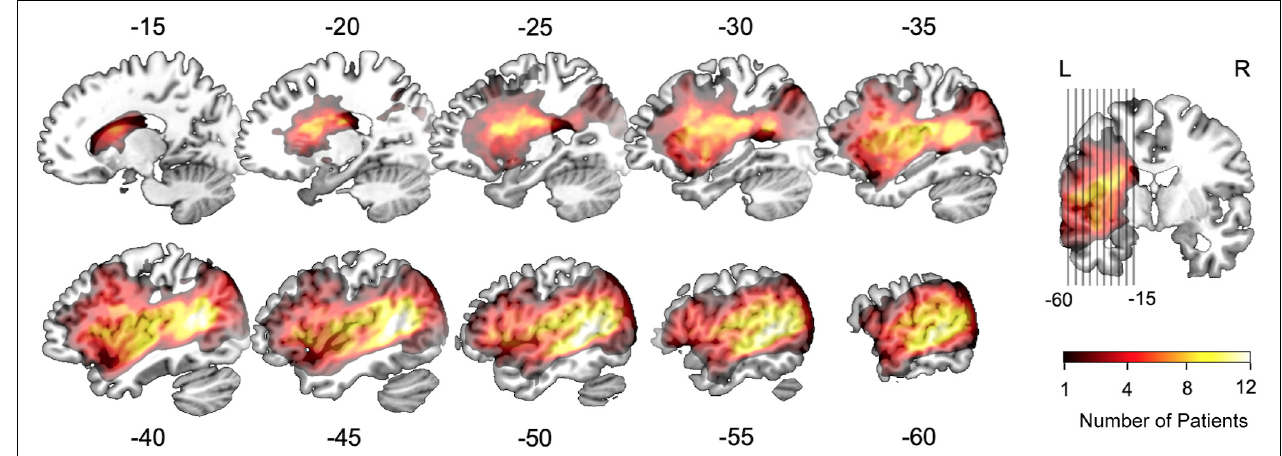
FIGURE 1 | Lesion overlap map of the aphasic group ( n = 19). The colored voxels depict left-hemisphere lesion distributions on the standard MNI-152 template. The color bar denotes the number of patients with a lesion in a given voxel between 1 and